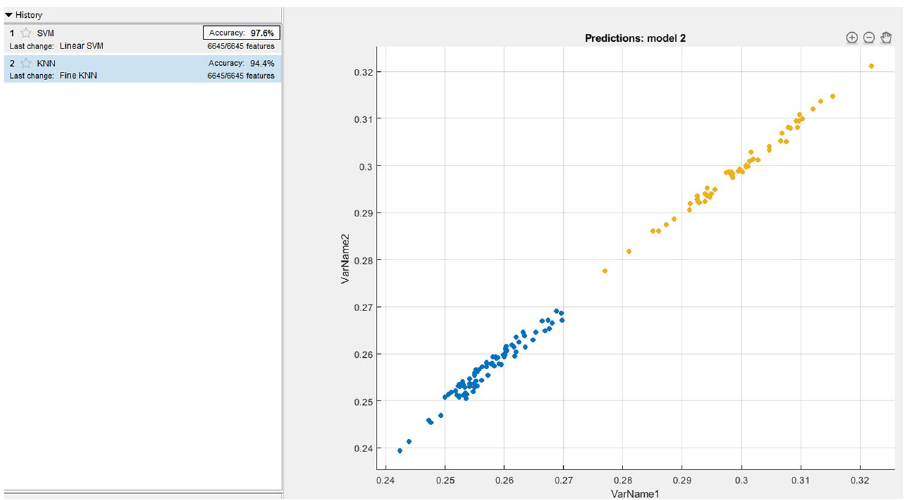
Figure 8. SVM and KNN analysis on QT